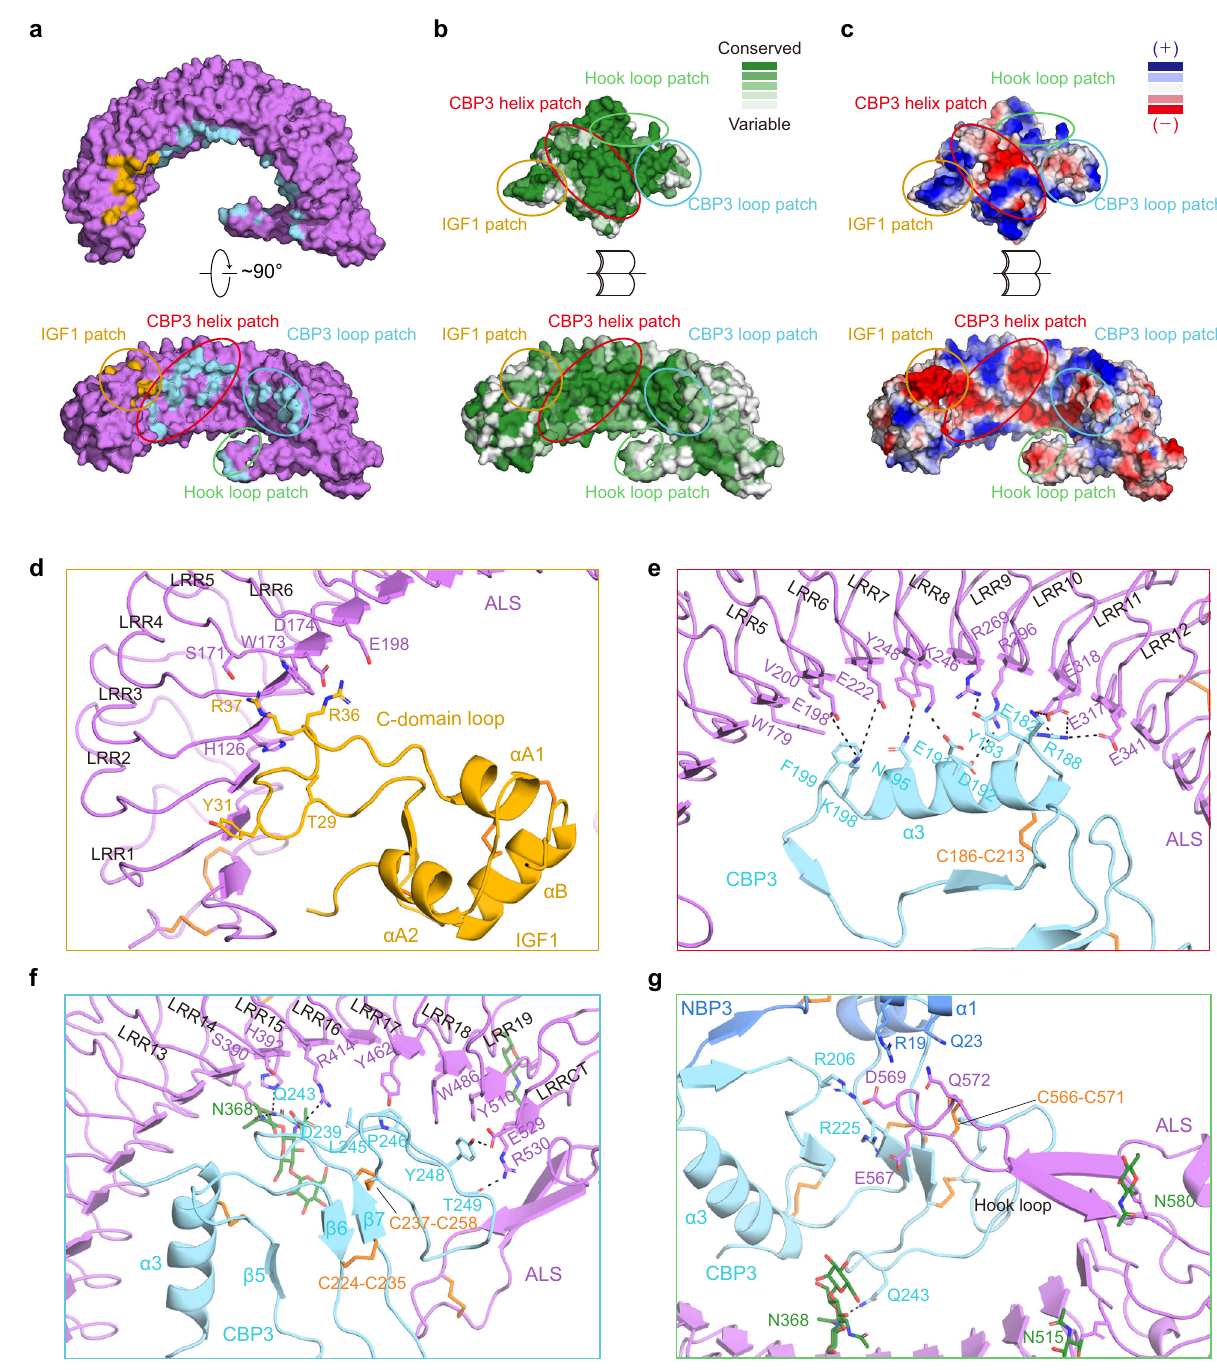
Fig. 3 | Detail of interactions between ALS and the IGF1/IGFBP3 binary com- plex. a The surface representation of ALS (violet) in two orthogonal views. ALS residues for IGF1 and CBP3 interaction are shown in yellow and cyan, respectively. b Sequence conservations were calculated by the Consurf server 65 and are pre- sented on the surfaces ofALS and the IGF1/IGFBP3 binary complex. The structures are shown as open-book views and surface representations, with color maps re fl ecting conservation (green, highly conserved; white, less conserved). The orientation of the surface view of ALS is identical to that in a (bottom). c Electrostatic potential of ALS and the IGF1/IGFBP3 binary complex, calculated according to the Poisson-Boltzmann equation in PyMOL. Blue and red represent positively and negatively charged residues, respectively. The orientation of the